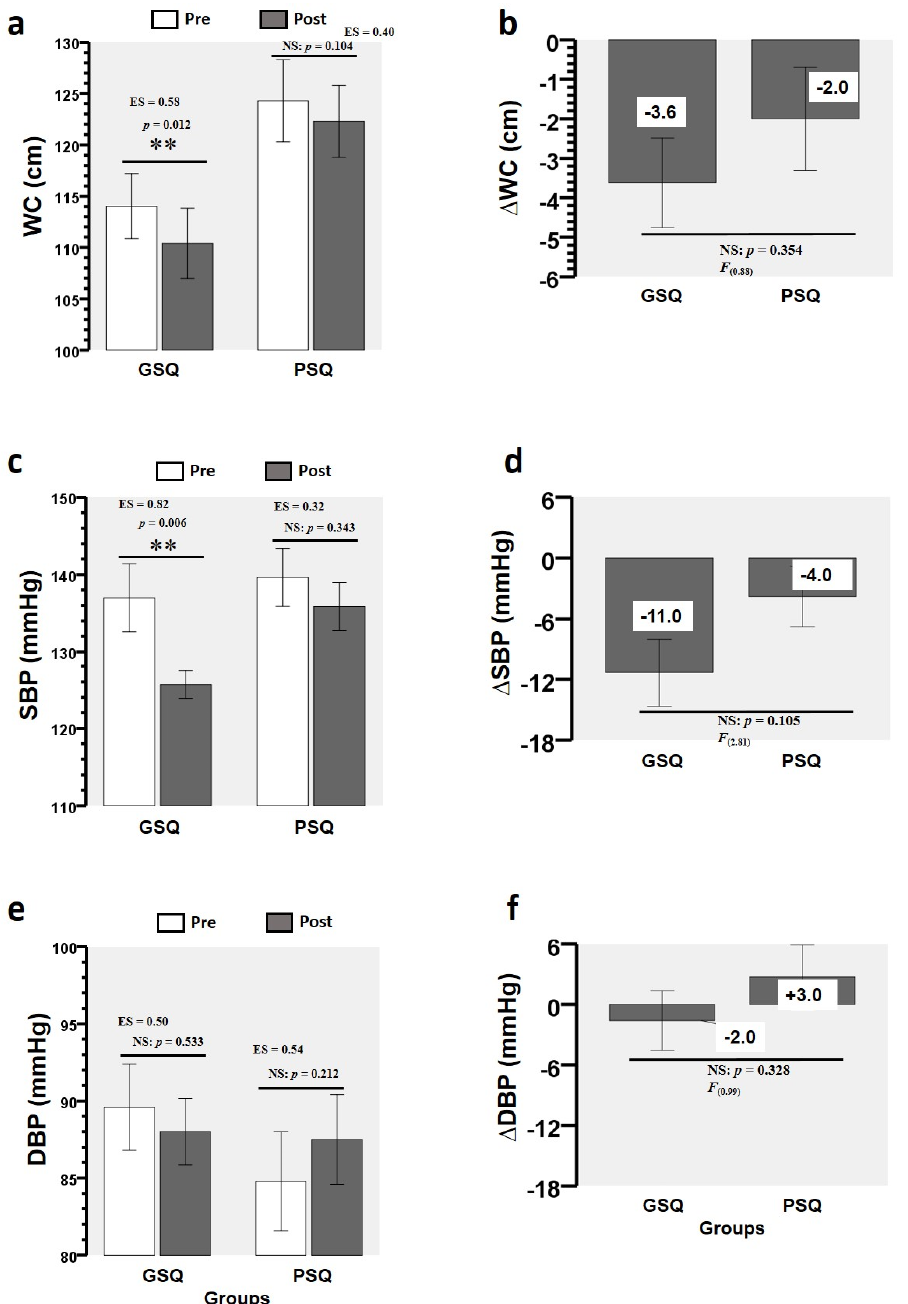
Figure 2. Changes in metabolic syndrome makers for each sleep-quality group. Abbreviations: DBP, diastolic blood pressure; GSQ, good sleep quality; PSQ, poor sleep quality; WC, waist circumference. ( ∆ ) denotes delta changes from pre to post intervention. (**) denotes significant differences between groups ( p < 0.01). (NS) denotes no significant differences. (ES) denotes effect size. (F) denotes the Levene test. After the CT programme, there was a change in the GSQ group between pre- and post-intervention WC (114.0 ± 3.1 vs. 110.4 ± 3.4 cm, ES = 0.58, p = 0.012), but no change in the PSQ group ( p = 0.104) ( a ). There was a difference in the pre- and post-intervention SBP for the GSQ group (137.0 ± 4.3 vs. 125.6 ± 1.8 mmHg, ES = 0.82, p = 0.006) but not for the PSQ group ( p = 0.343) ( c ). There were no differences in pre- and post-intervention DBP for the GSQ ( p = 0.533) and PSQ ( p = 0.212) groups ( e ). There were no time × group interactions for the ∆ WC ( b ), ∆ SBP ( d ), and ∆ DBP ( f ) comparisons between